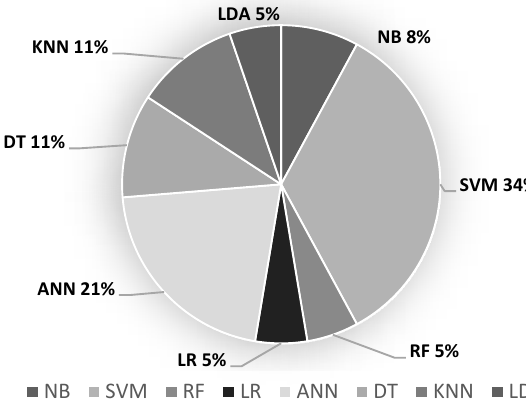
Figure 4. Prevalence of classification models.